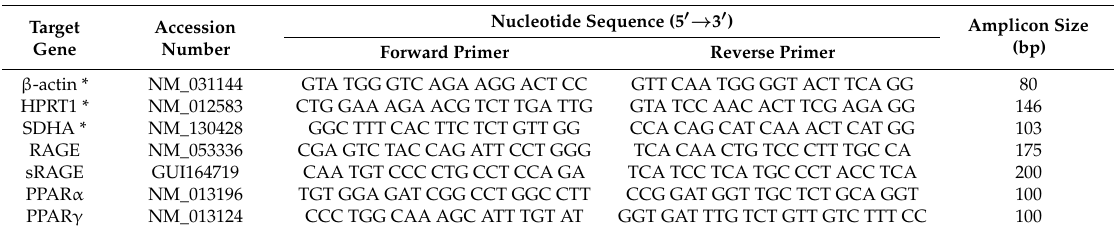
Table 2. Accession numbers, forward and reverse primers of the endogenous reference, and target genes as well as amplicon size of the PCR